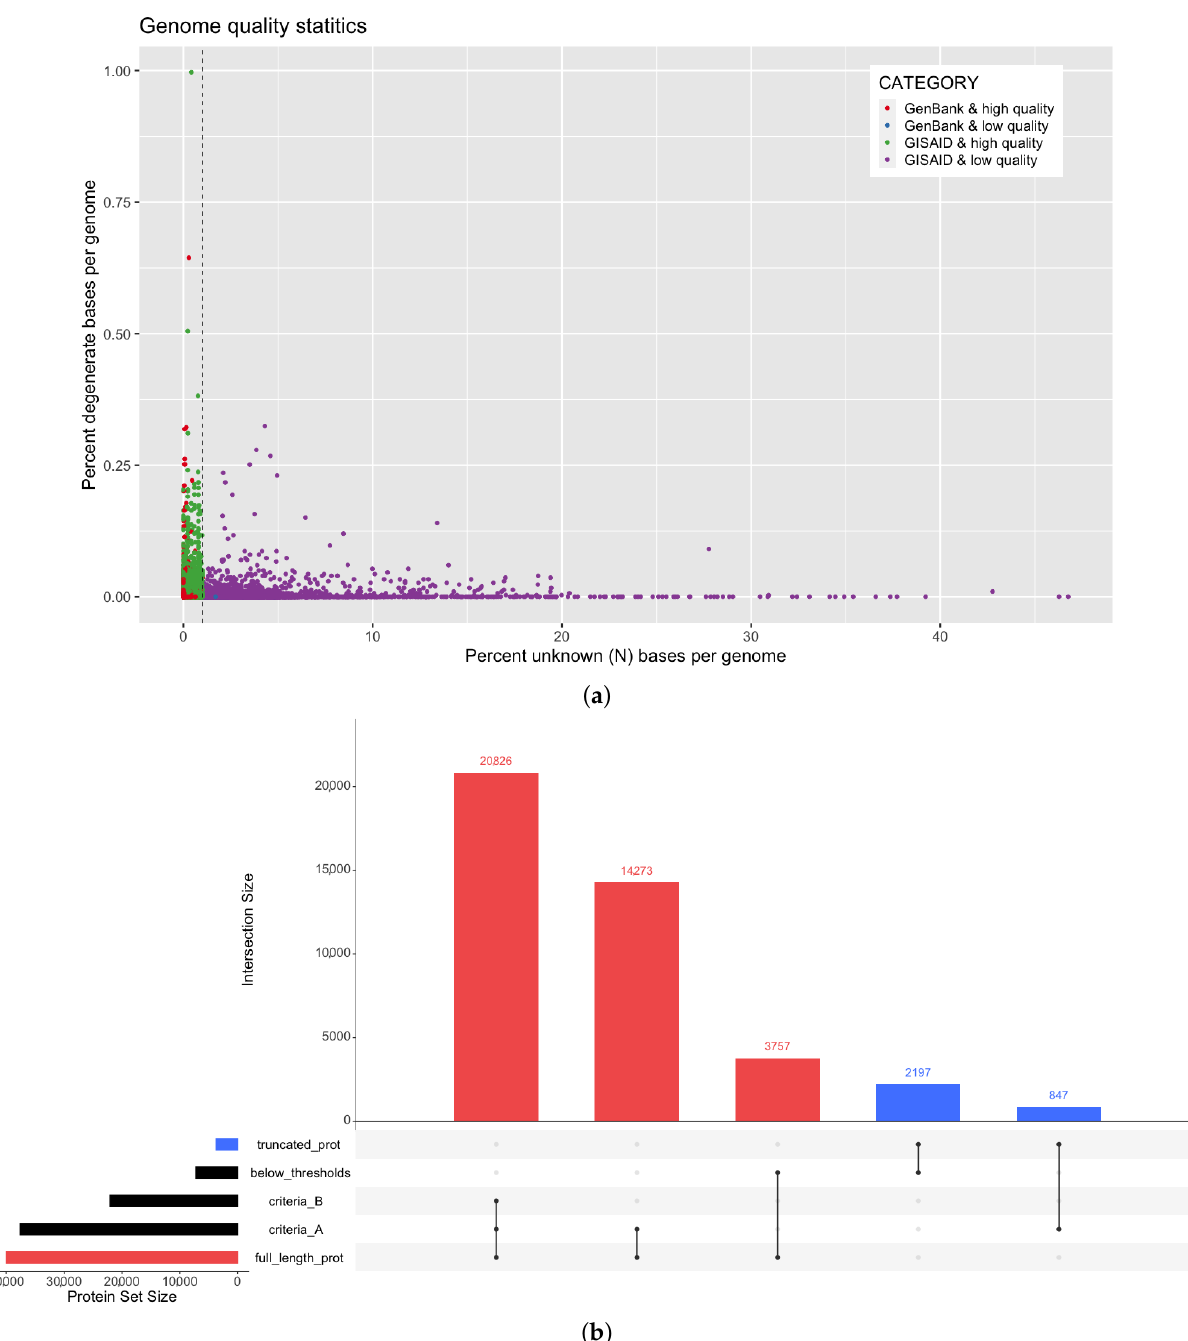
Figure 2. SARS-CoV-2 genome quality observations and their effect on annotation results. ( a ) The percent of unknown (N) and degenerate bases (as defined by IUPAC) are calculated as a function of total genome size for SARS-COV-2 genomes from two sources: NCBI GenBank and GISAID. The quality threshold of unknown bases is indicated with a dashed line. ( b ) Full length (red) or truncated (blue) protein products are indicated for genomes by quality criteria status: our selected criteria (Criteria A), more stringent criteria (Criteria B), or below quality thresholds. In this upset plot for each vertical bar, the categories defining the intersection are indicated with filled-in dots. For example, the first bar represents the number of proteins that pass both Criteria A and B and are also full length proteins, whereas the second bar represents the number of full length proteins that pass Criteria A but not Criteria B and are still full length. For criteria definitions, see Section